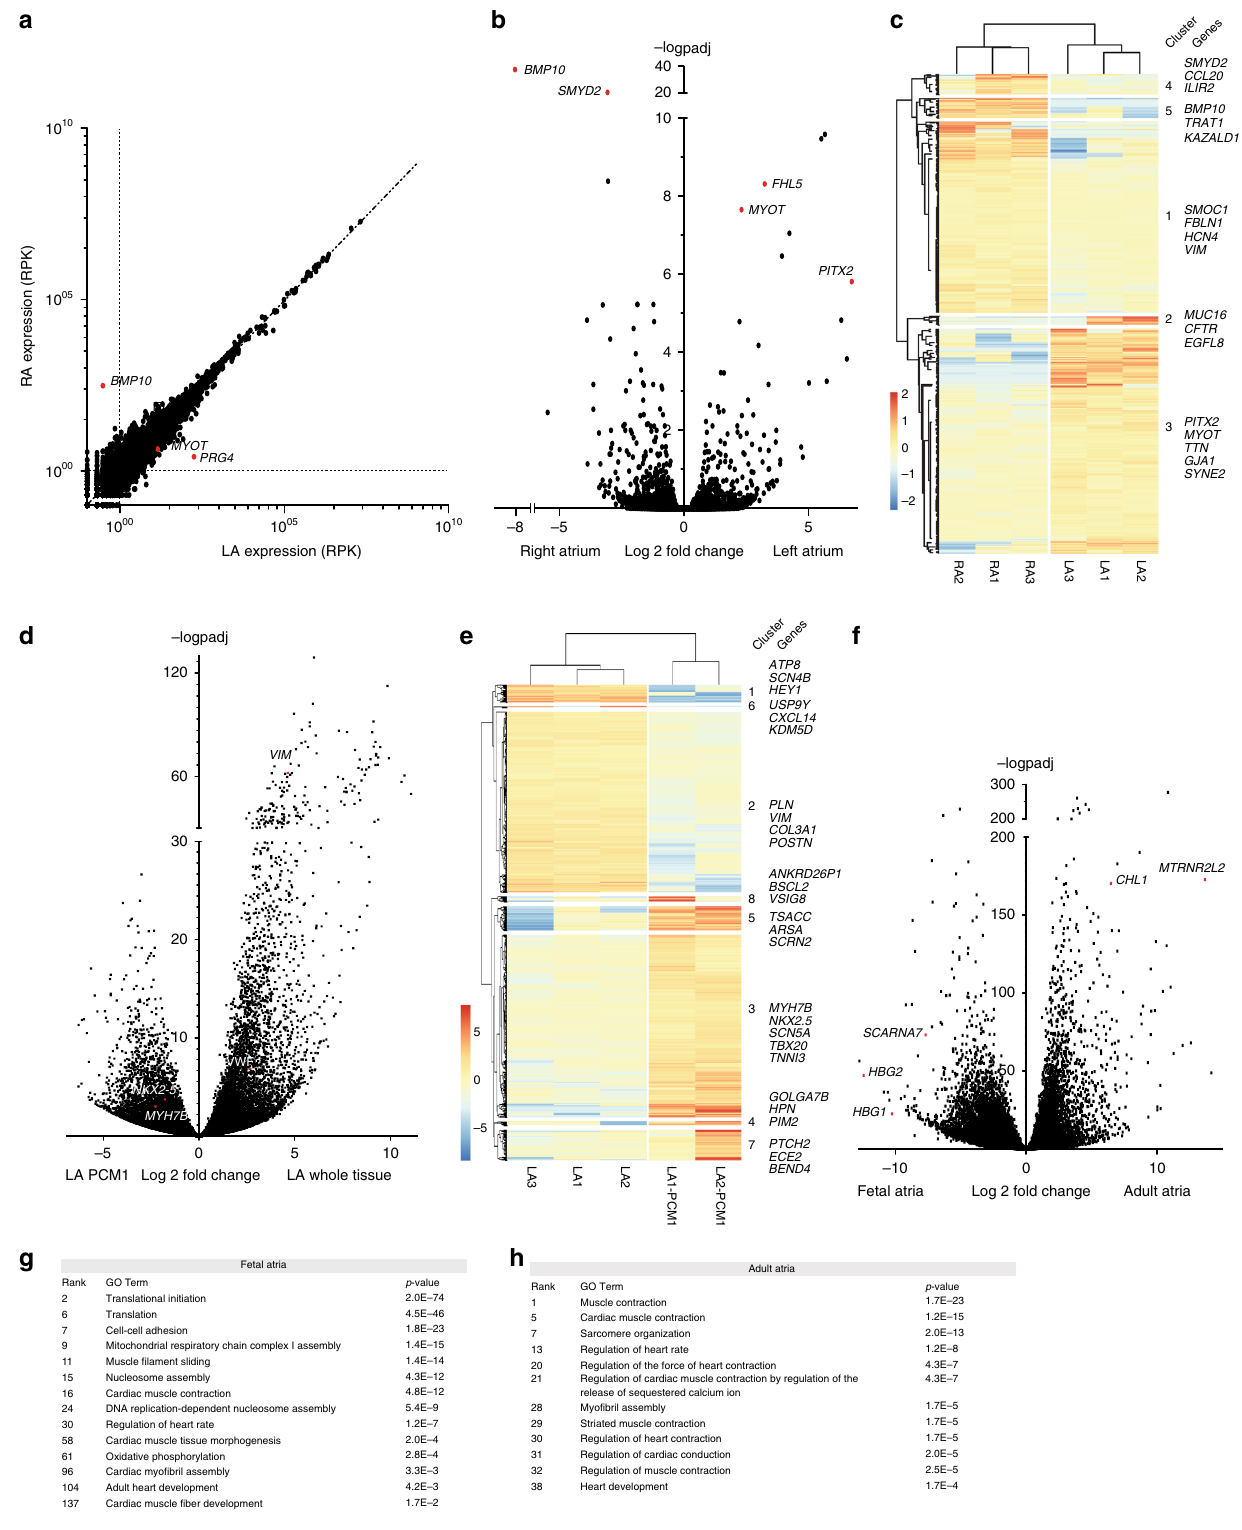
Fig. 1 RNA-seq of human adult and fetal atria. a MA plot of left atrial and right atrial whole tissue expression (RPK). A total of 15,239 genes with RPKs > 1 are detected in both samples. b Volcano plot analysis of left versus right adult atrial expression. c Heatmap of left and right atria ( n = 3) shows that these tissues cluster together. d Volcano plot of adult left atrial tissue versus PCM1-sorted left atrial nuclei (i.e., CM nuclei). e Heatmap of whole tissue ( n = 3) and PCM1-enriched left atria ( n = 2). f Volcano plot analysis of adult ( n = 3) versus fetal ( n = 2) atrial expression. g GO terms of top 500 expressed genes in fetal atria with rank and p -value. h GO terms of top 500 expressed genes in adult atria with rank and p -value. p -values were calculated using DAVID (based on Fischer-exact test) and Benjamini-Hochberg corrected. RPK reads per kilo base, PCM1 pericentriolar material 1, GO Gene